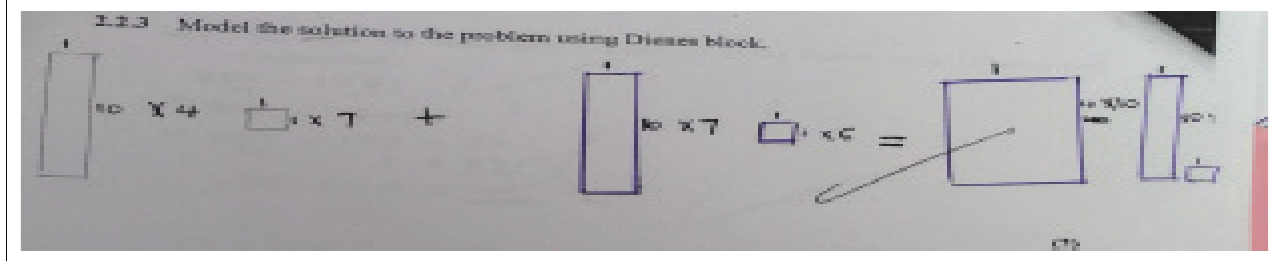
FIGURE 12: Sample of students’ response to item